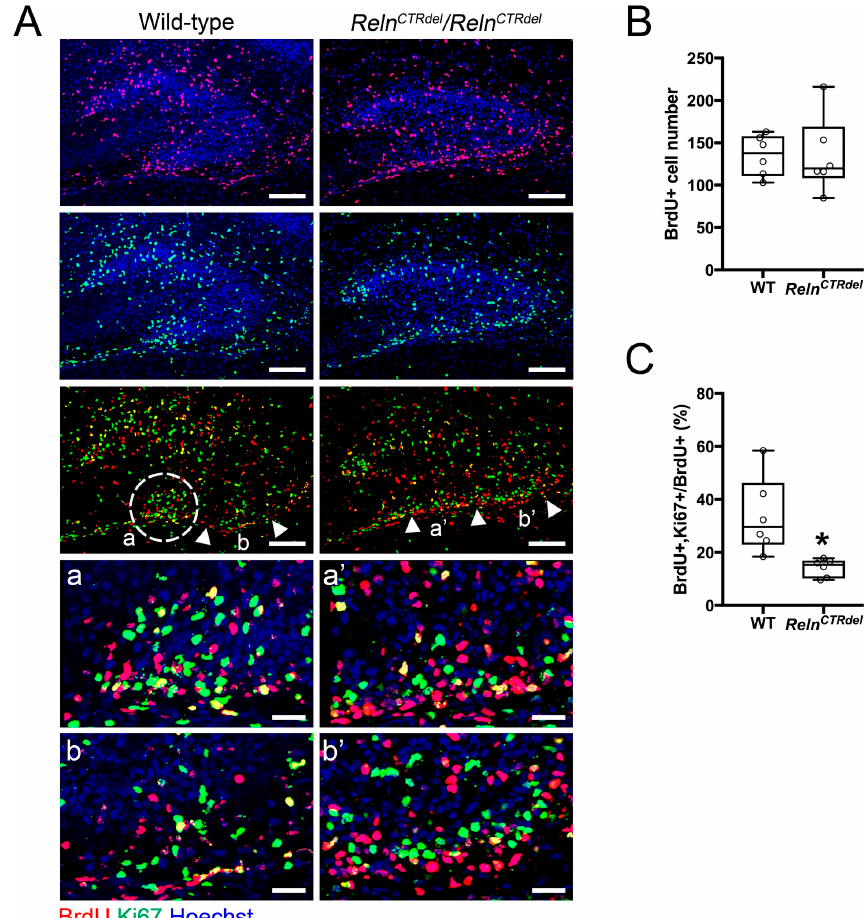
Figure 2. Absence of the neurogenic cluster at the fimbriodentate junction. ( A ) Distribution of the BrdU (red) or Ki67-positive cells (green) in the dentate gyrus at P4, after 24 h from BrdU injection. A cluster of dividing cells is present at the fimbriodentate junction of the wild-type (white circle, a). A Reln CTRdel mutant does not have this cluster (a’). Compared with a corresponding region of the wild type (b), abnormal accumulation of the dividing cells are apparent in the subpial surface of Reln CTRdel (b’). Enlarged images of marked regions (a, a’, b, b’) are shown below. In the mutant, Ki67-positive cells are closely located on top of BrdU-positive cells (a’ and b’). Scale bars, 100 µ m. Scale bars in the enlarged images, 25 µ m. Nuclei were stained using Hoechst (blue). ( B ) The number of total BrdU-positive cells is not significantly di ff erent ( p = 0.8182; boxplot, median ± IQR; whiskers, min and max). ( C ) The percentage of BrdU / Ki67 double-positive cells was reduced ( p = 0.0022; boxplot, median ± IQR; whiskers, min and max). This represents a population of cells that reentered the cell cycle.